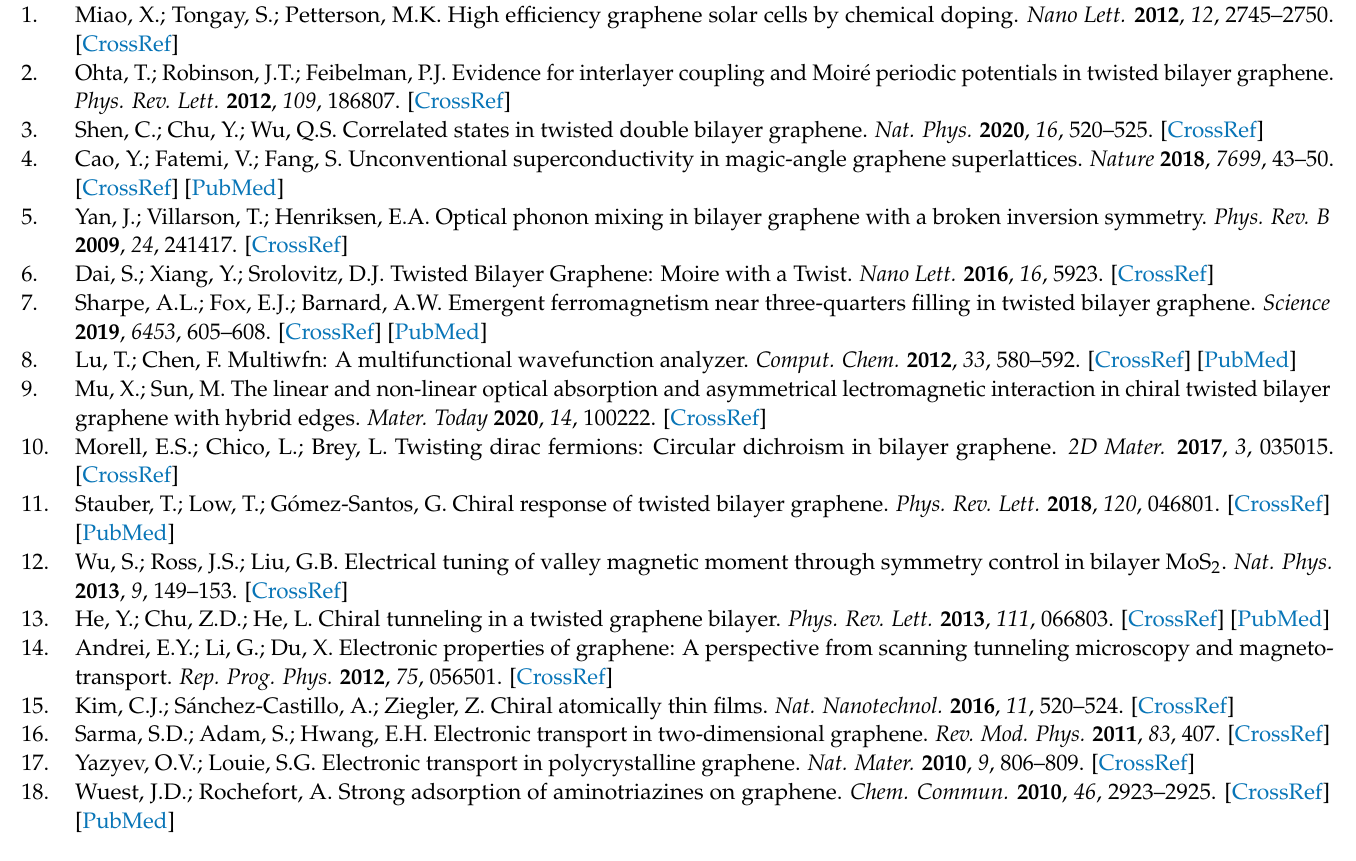
function values of the RCP in Coronene, Table S4: The real space function values of the RCP at the Moir é in top (T) and underlying (U) layer Z-TwBLG-QDs-27.8 ◦ , Table S5: The real space function values of the RCP at the Moir é in top (T) and underlying (U) layer of Z-TwBLG-QDs-32.2 ◦